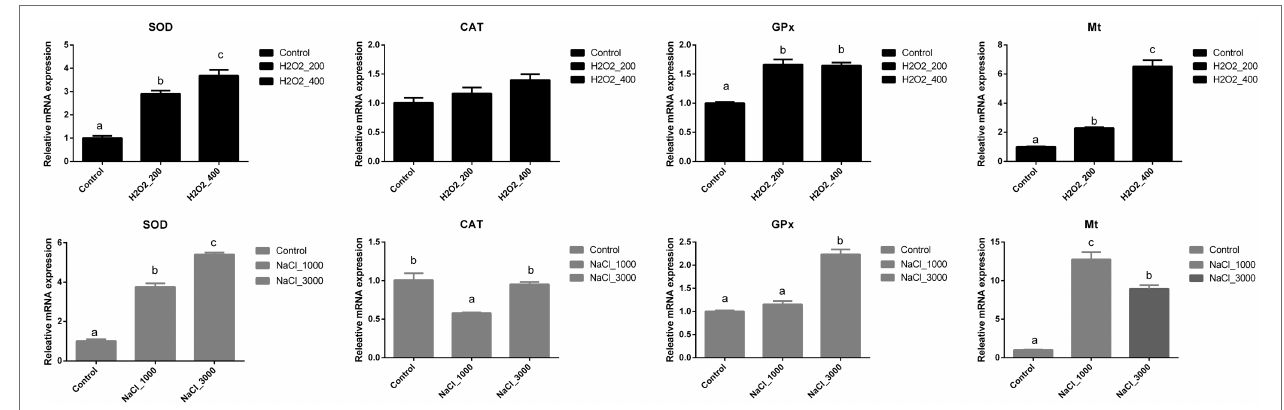
FIGURE 3 | Effects of H 2 O 2 (200, 400 mg/ml) and NaCl (1,000, 3,000 mg/ml) pre-treatment during egg hatching on the relative expression levels of genes involving antioxidant capacity, including SOD, CAT, GPx, and Mt in loach